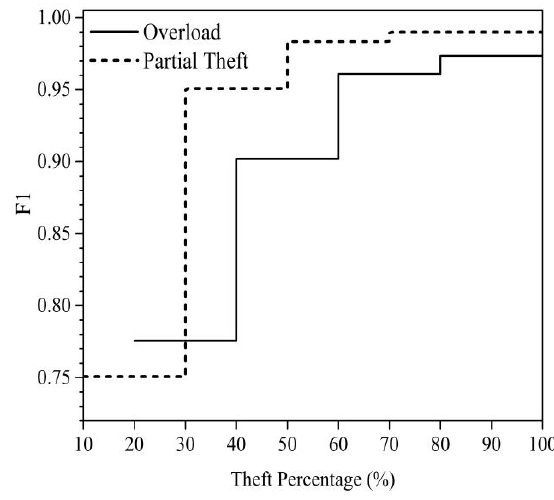
Figure 8. Accuracy metric for partial power theft and overload scenarios.